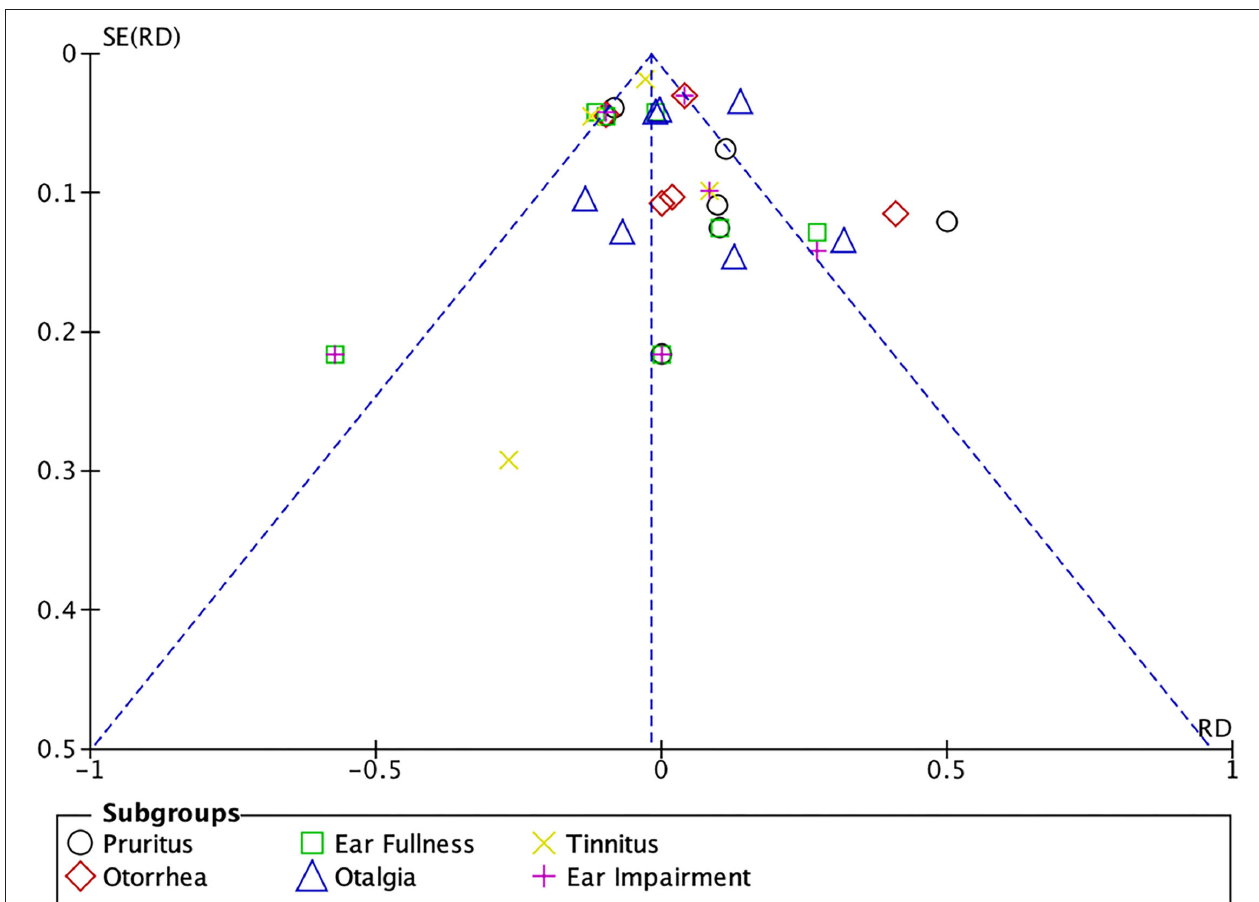
FIGURE 9 | Funnel plot of complications associated with the two drug regimens analyzed in the